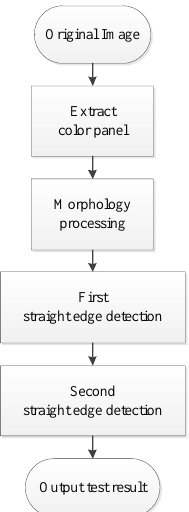
Figure 2. Flowchart of vehicle target recognition scheme.